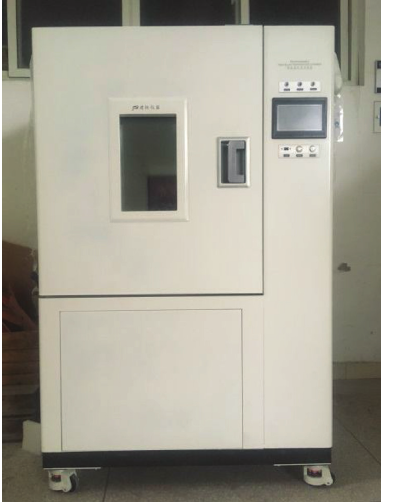
Figure 4: The constant temperature and humidity